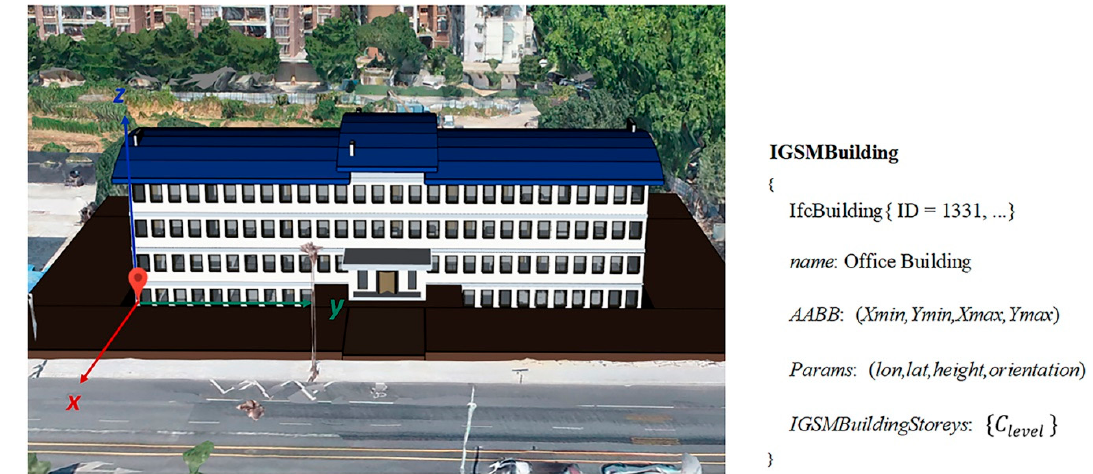
Figure 5. Diagram of IGSMBuilding.